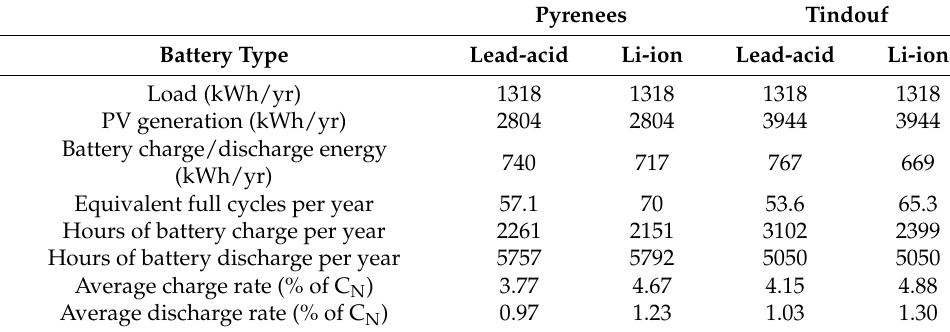
Table 3. Results of the simulation during a whole year for the different